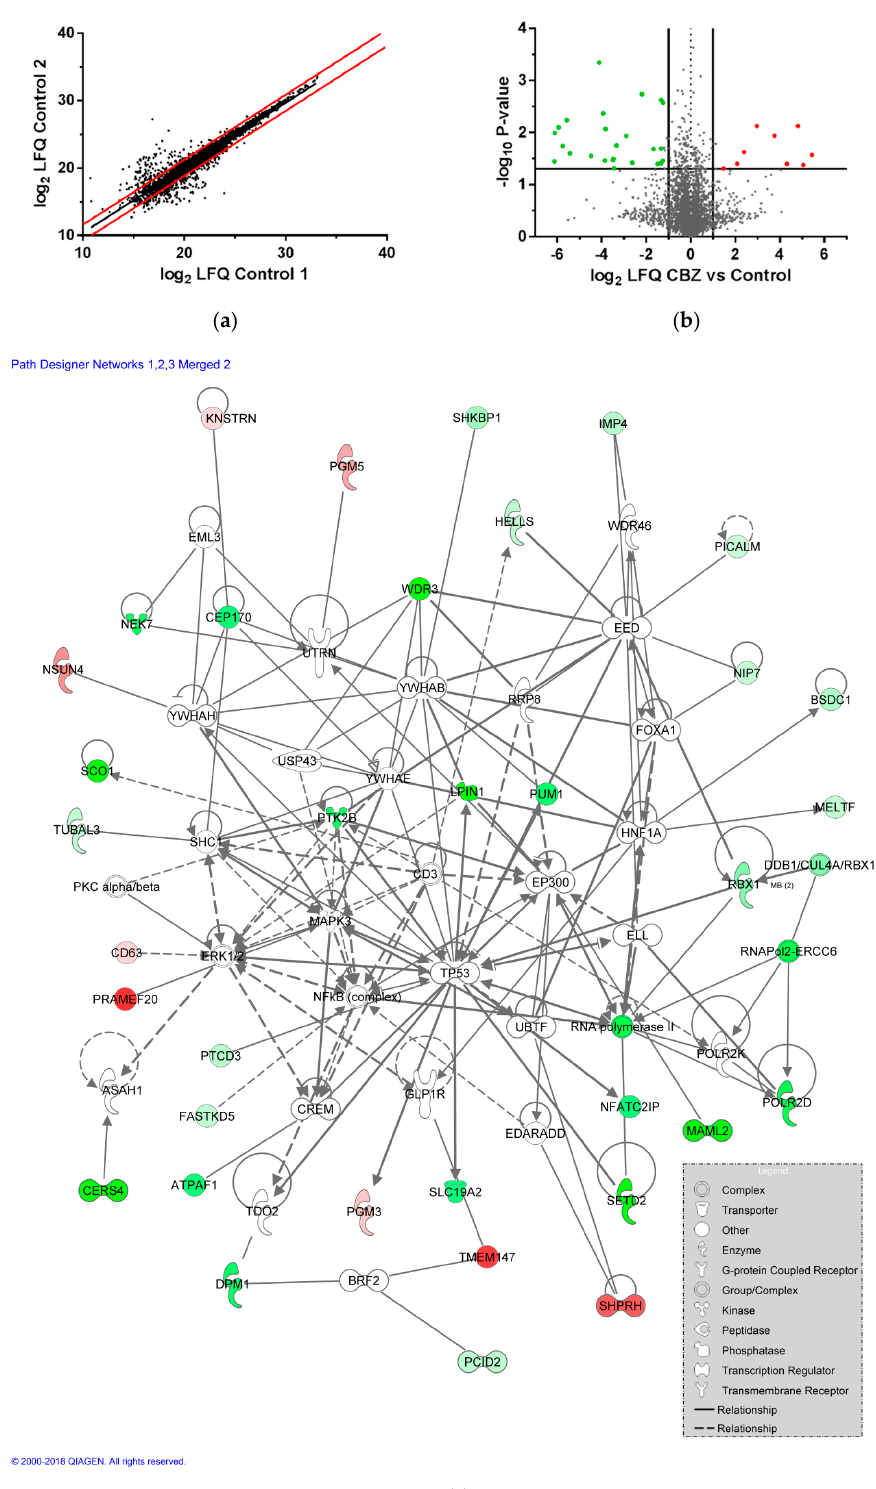
Figure 5. Mass spectrometric analysis of the proteome of LCL721.221 cells expressing sA*31:01 ( a ) LFQ intensities spread of the proteome for untreated recombinant B-LCL cells transduced with sHLA-A*31:01. Protein intensity ratios of LC-MS analyzed untreated control replicates, depicted as log2-values, were plotted against each other. Regulation limits were determined through 95% confidence range (red lines) and set to log2 ± 1.2; ( b ) Protein abundance after CBZ treatment. Results are shown as a volcano plot. Protein abundance of two independent replicates is plotted as log2 value against the negative decadic logarithm of the p -values. Proteins were regarded as regulated from factor 1.2 and p -value < 0.05. Significantly upregulated proteins due to CBZ treatment are shown in red and downregulated proteins in green; ( c ) Network analysis for up- and downregulated protein groups following CBZ treatment. Upregulated proteins are illustrated in red, downregulated proteins are illustrated in green, not colored proteins were added by the IPA algorithm. High confident interactions are symbolled by a continuous line; medium confident interactions are symbolled by a dashed line.